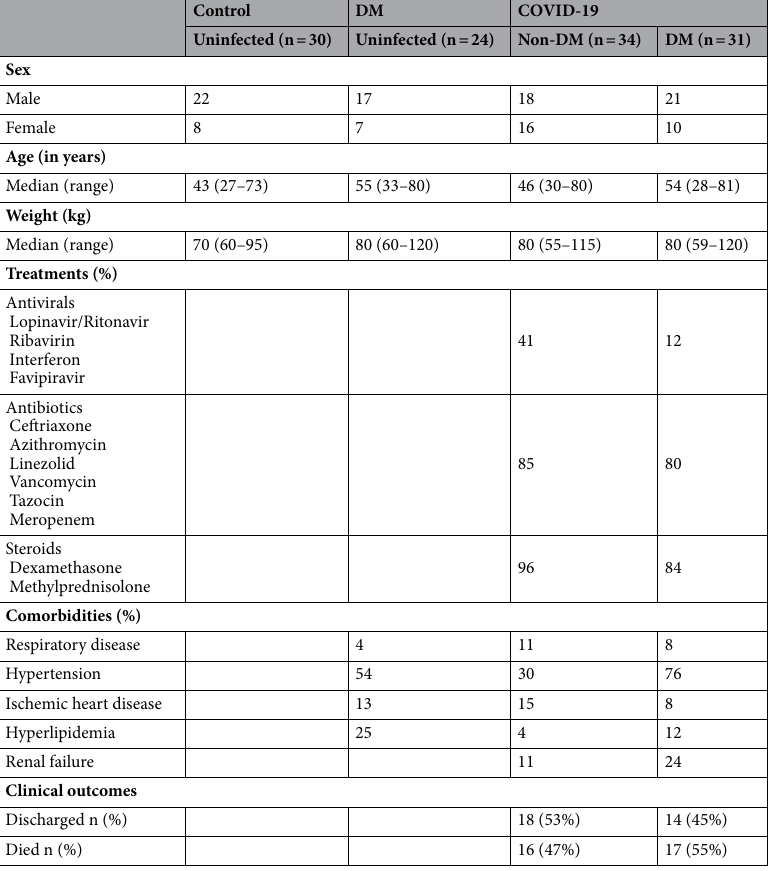
ferences in the mean age and weights of uninfected DM patients and infected patients. Uninfected individuals without DM were slightly younger and weighed less than ICU patients. There were twice as many males than females in this cohort of patients. A higher percentage of non-DM patients were on antiviral regimens than DM patients (41% vs 12%). Similar percentages of non-DM than DM patients were on antibiotics and steroids. Co- morbidities are also shown in Table 1. Of the thirty-four non-DM patients, sixteen died (47%), and seventeen of thirty-one DM patients died (55%). The blood analyte profile of patients used in this study are shown in Table 2. They were divided into five groups: individual tests, blood cell/coagulation parameters, renal function parameters, liver function param- eters and lipid profiles. Blood glucose levels in ICU COVID-19 patients without DM were higher than that of un-infected individuals. Neutrophils were higher, and lymphocytes basophils and eosinophils were lower in ICU COVID-19 patients. There were no changes in monocytes levels between non-infected controls and ICU COVID-19 patients. Ferritin was also elevated, and hemoglobin and hematocrit were lower in ICU COVID-19 patients. There were no significant differences in Na + , K + , Cl − , Ca 2+ , phosphorous, and Mg 2+ levels between unin- fected and ICU COVID-19 patients. However, albumin levels were lower, and urea was higher. Liver enzymes were also higher in ICU COVID-19 patients. Plasma levels of MG, glutathione, Glo1, SSAO, TNF‑α, IL‑1β, CRP in ICU COVID‑19 patients. Plasma levels of MG, glutathione, and the inflammation markers SSAO, TNF-α, IL-1β, CRP, but not Glo1, were significantly higher in all ICU patients compared to uninfected individuals (Fig. 1A–G). MG was significantly higher (77%), and glutathione and Glo1 were significantly lower (44% and 43% respectively) in plasma in patients that died compared to ICU patients that survived (Fig. 2A–C). There were no significant dif- ferences in plasma levels of SSAO, TNF-α, IL-1β, and CRP between patients that died and survived (Fig. 2D–G). Immune cells in ICU COVID‑19 patients. Since upregulation of glycolysis in immune cells is required to orchestrate their highly specific series of responses to clear viral infection and repair cellular damage, we measured immune cells levels in ICU patients. Neutrophils were significantly higher, and lymphocytes, baso- phils, and eosinophils were significantly lower in ICU COVID-19 patients compared to uninfected individuals (Fig. 3A,B,D,E, respectively). No significant difference was found in the amounts of monocytes in ICU COVID-